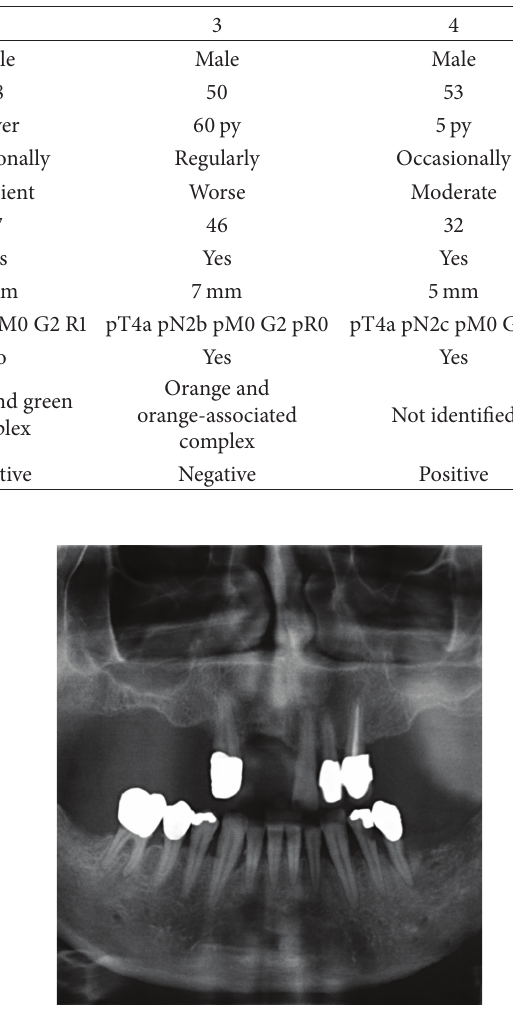
Figure 12: Case 4—preoperative OPTG. A general horizontal loss of bone in both jaws with additional vertical translucencies in the front aspect of the mandible and signs of erosion of the alveolar crest at the left lower